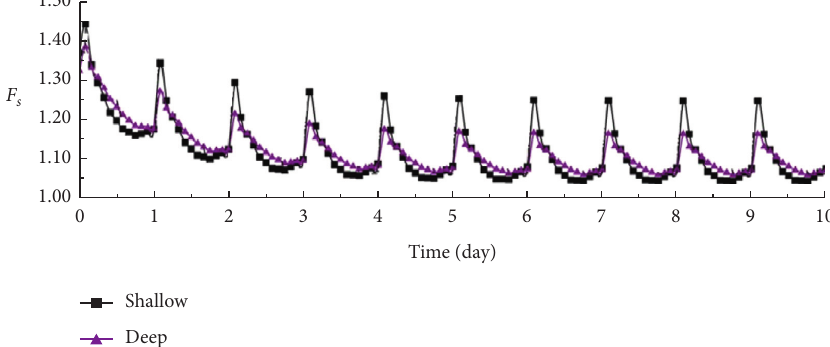
Figure 15: Evolution characteristics of stability coefficient of ice-snow melting.